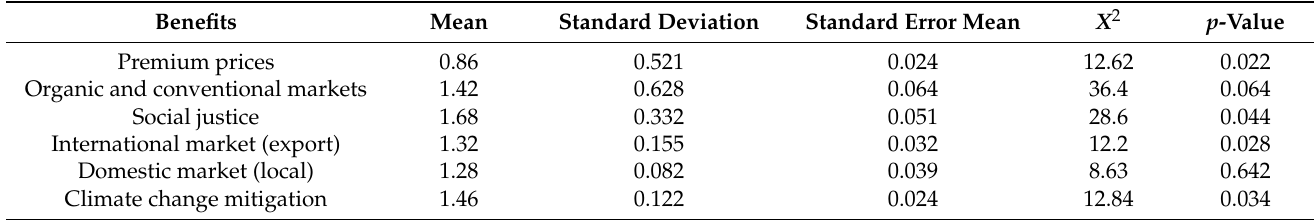
Table 5. Descriptive statistics of perceived benefits of organic farming by farmers.